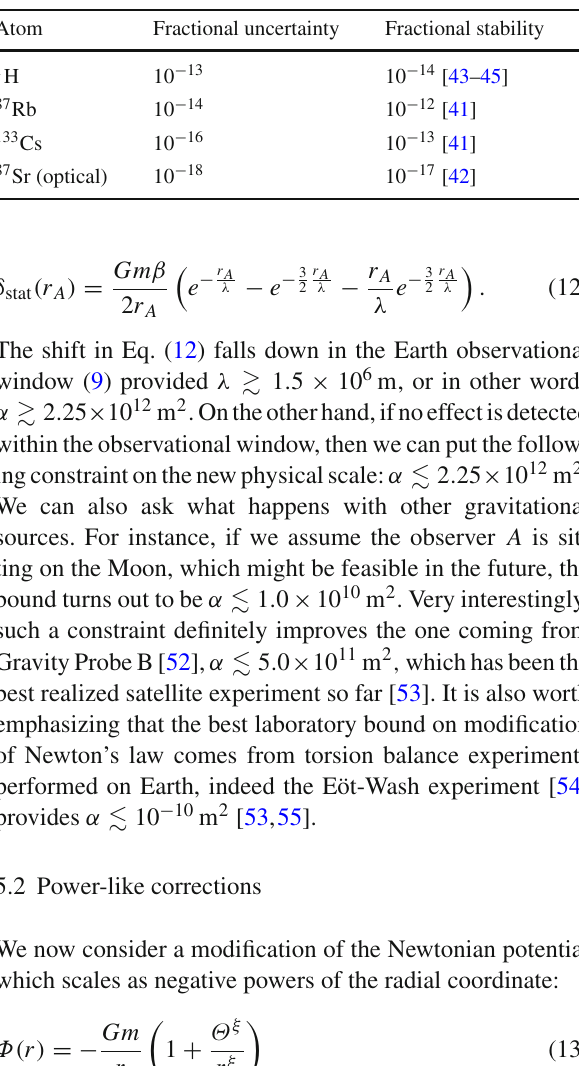
Table1 Severalatomicclockswithcorrespondingfractionalfrequency and fractional stability at 1